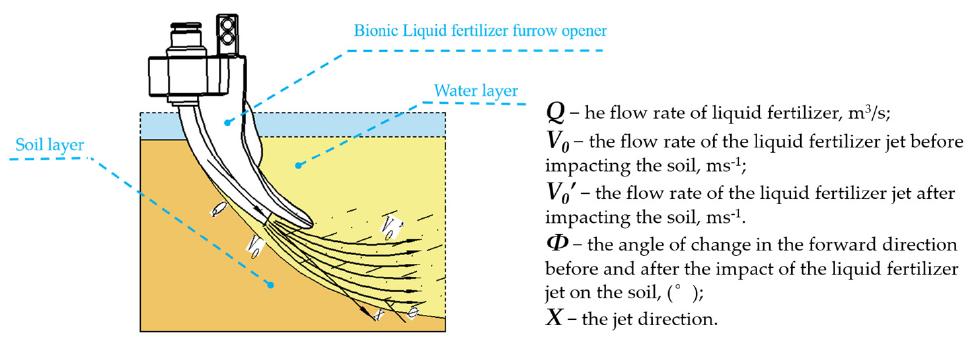
Figure 14. Liquid fertilizer jet erosion soil surface map.